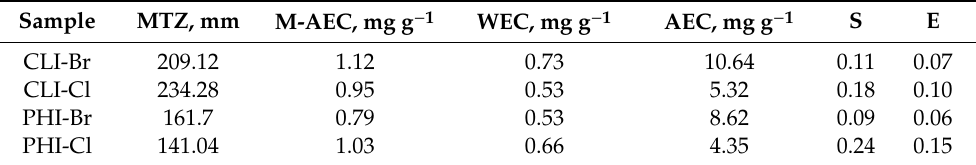
Table 5 . Dynamic parameters from breakthrough curves. Table 5: the PHI-based samples showed the shortest MTZ, while CLI-based the longest one. Table 5. Dynamic parameters from breakthrough